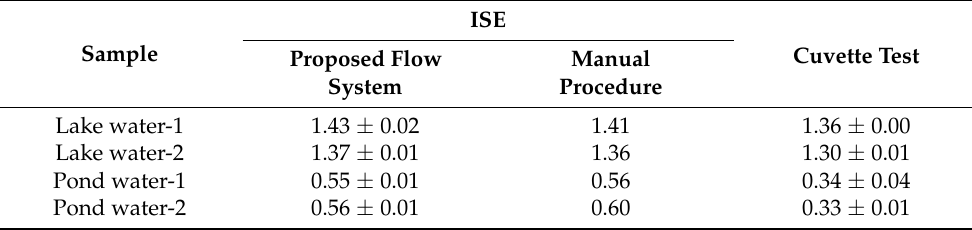
Table 3. Results of determination of log CNO 3 − ions concentration in lake and pond water. The results represent the average of at least four determinations ±